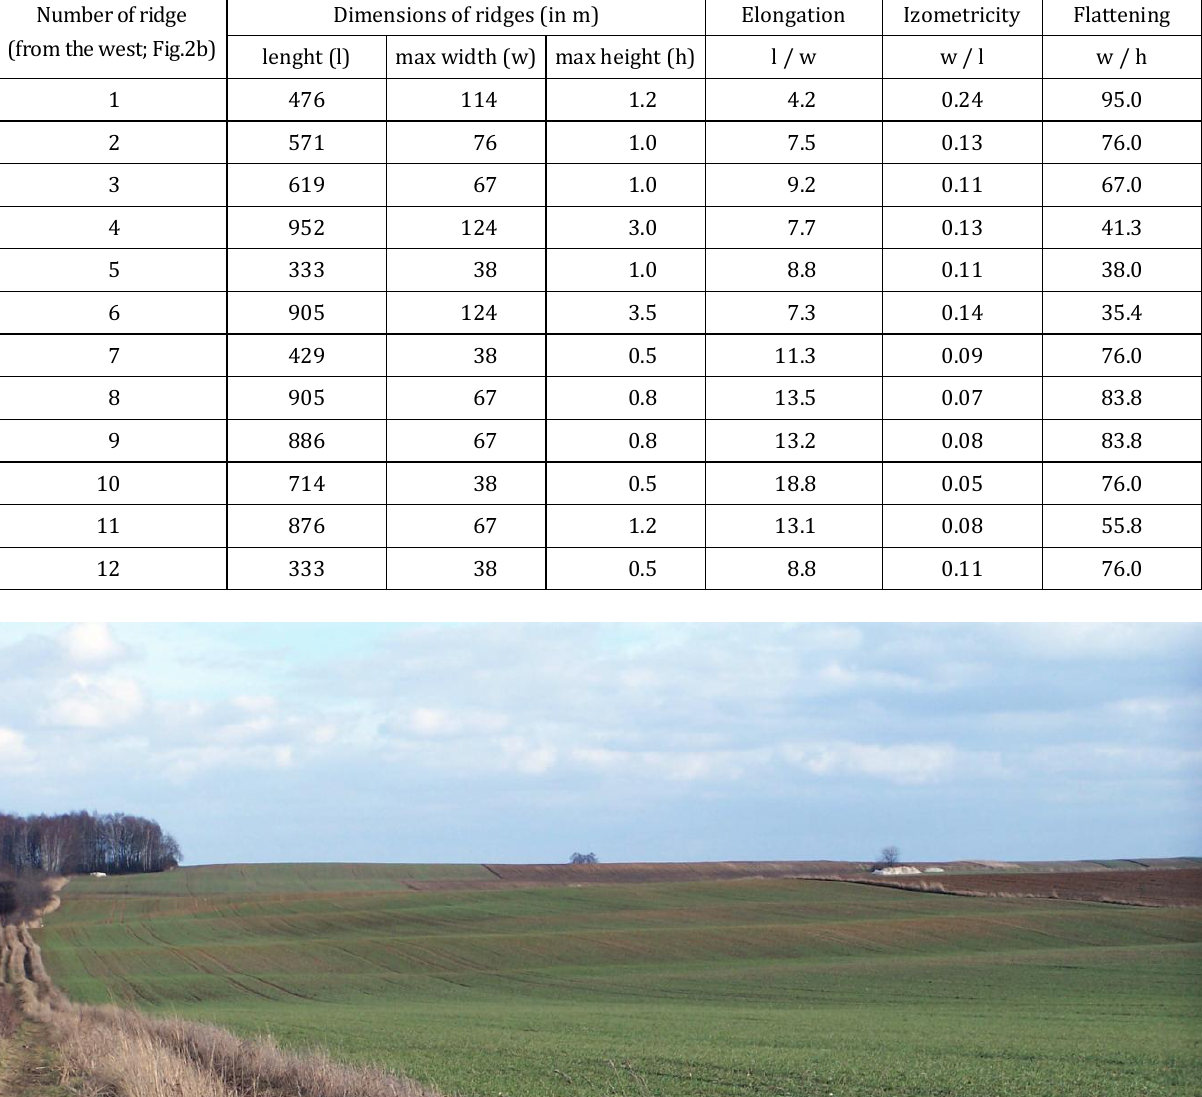
Table 1. Morphometric parameters of glacigenic ridges in Dolisko